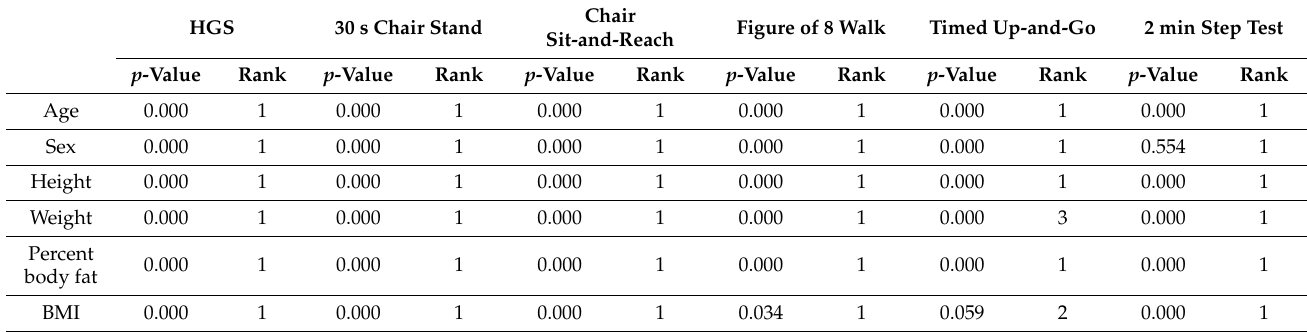
Table 3. p -values and Boruta feature selection of each independent